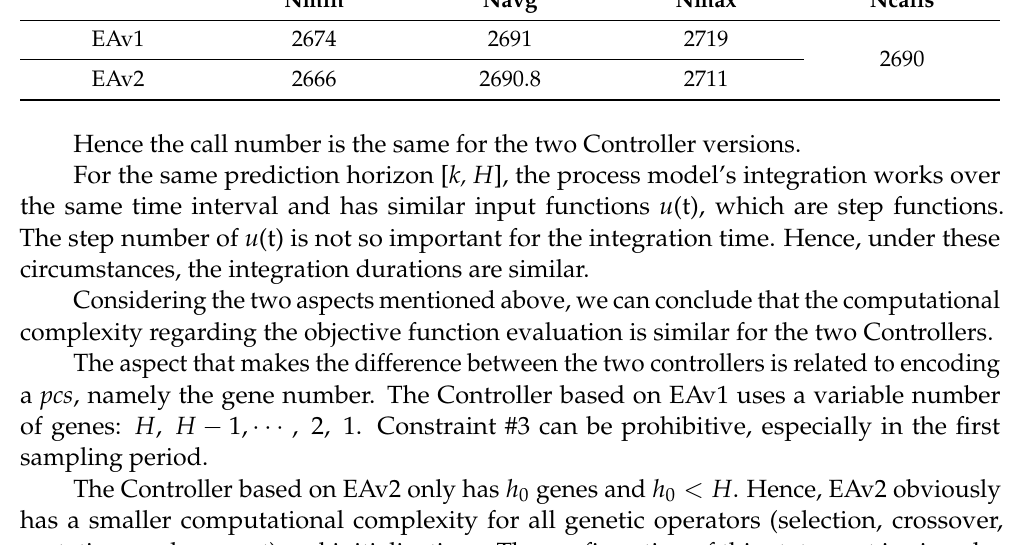
Table 8. The call number of the objective function. Nmin Navg Nmax Ncalls EAv1 2674 2691 2719 EAv2 2666 2690.8 2711